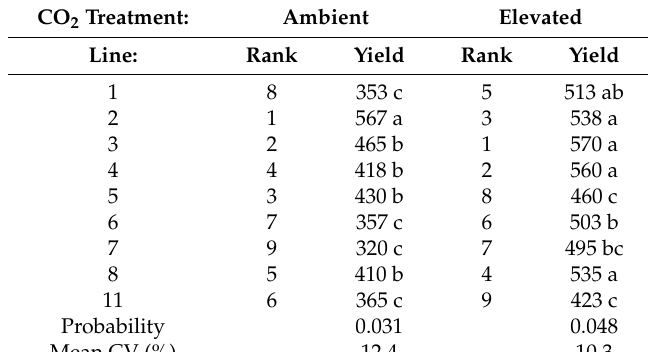
The coefficient of variation for averaged 11% across lines within each plot, for both experiments (Tables 1 and 2), that is both for a subplot size of 3.0 m 2 in the first experiment, and 0.20 m 2 in the second experiment. The coefficient of variation averaged the same at ambient and elevated CO 2 in both experiments (Tables 1 and 2). Homogeneity of variance tests also indicated no significant differences in variance among lines in either CO 2 treatment in either experiment.